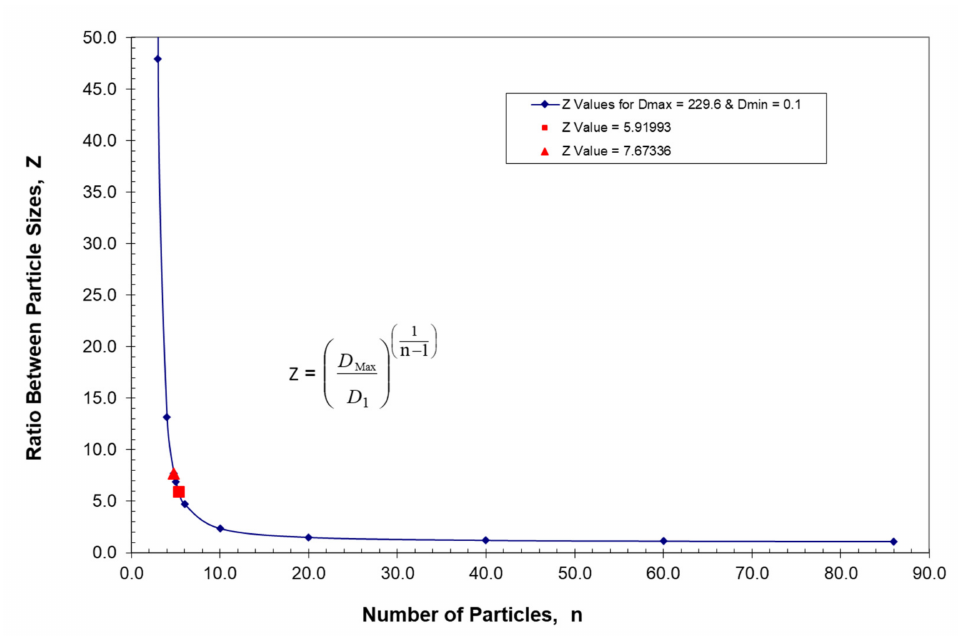
Figure 13. Ratio between particles, Z, vs. number of particles with a constant